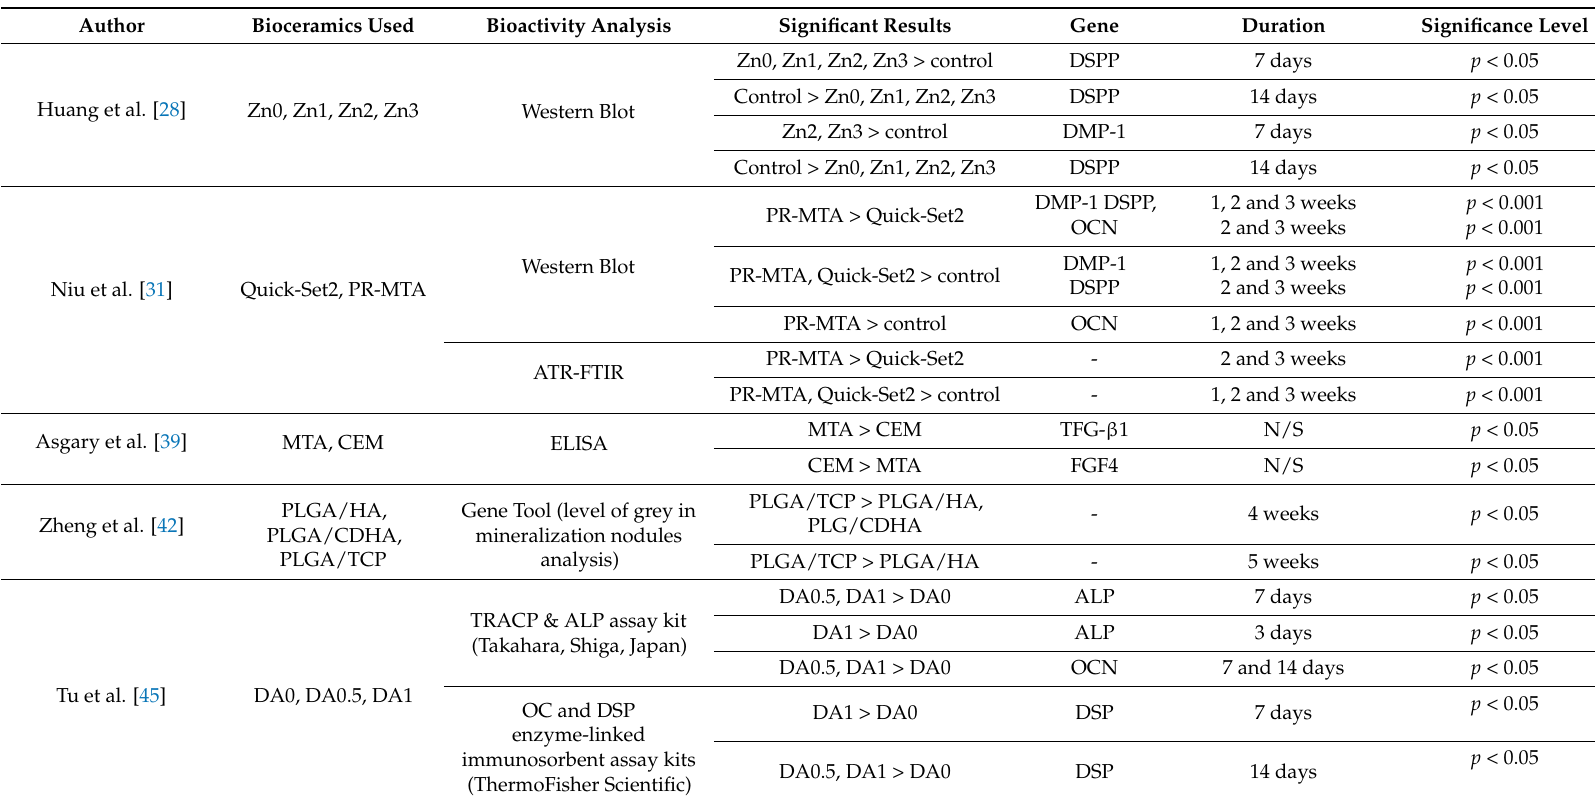
Table 17. Summary of the results of included studies showing significant differences for another bioactivity-related